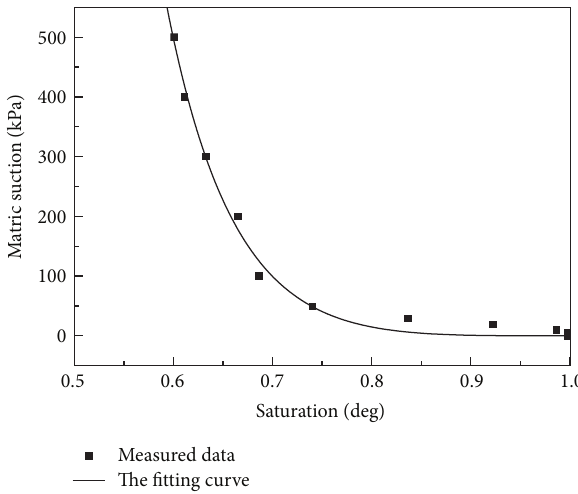
Figure 4: The fitting tested curve of SWRC for the completely decomposed granite soil (measured data from Hossain and Yin